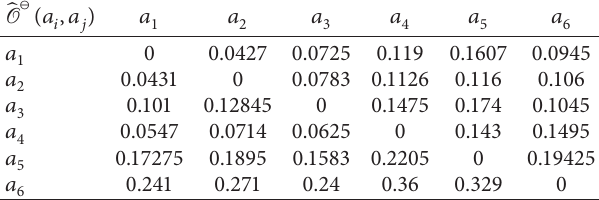
Table 3: The overall lower preference indices among drugs.